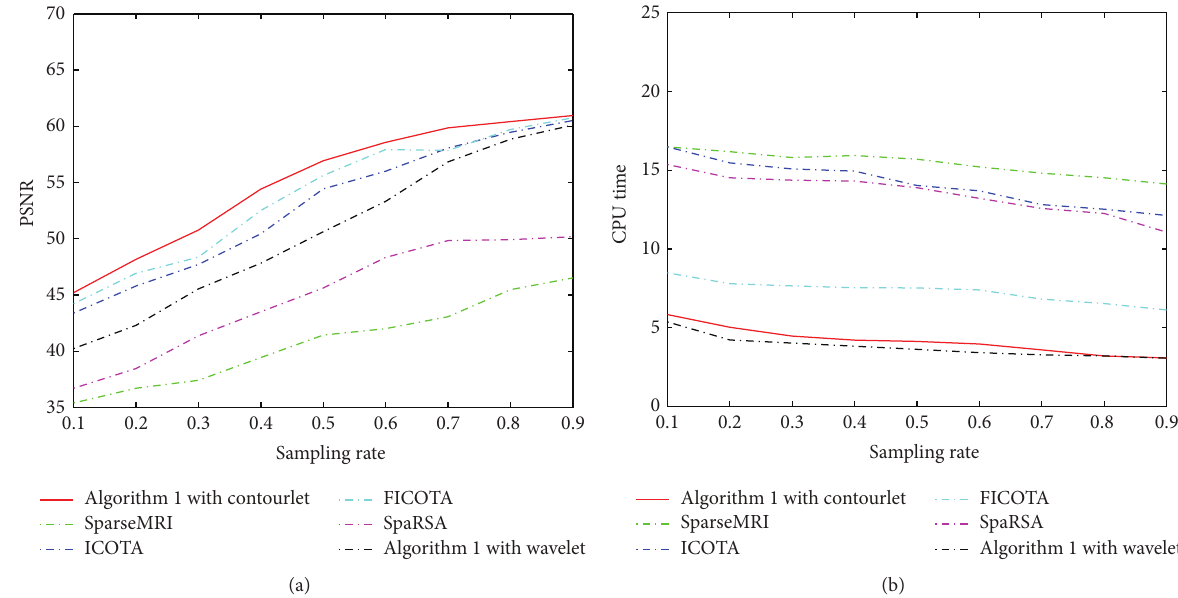
Figure 2: Comparison of CS-MRI reconstruction results obtained from different algorithms with different sampling rates. The results are average of 50 runs. (a) PSNR versus sampling rate. (b) CPU time versus sampling